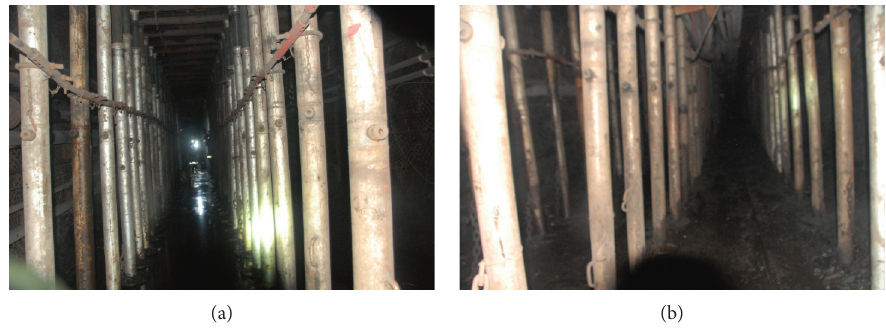
Figure 10: Roadway in the mining-induced advanced abutment pressure area of the fracturing area.